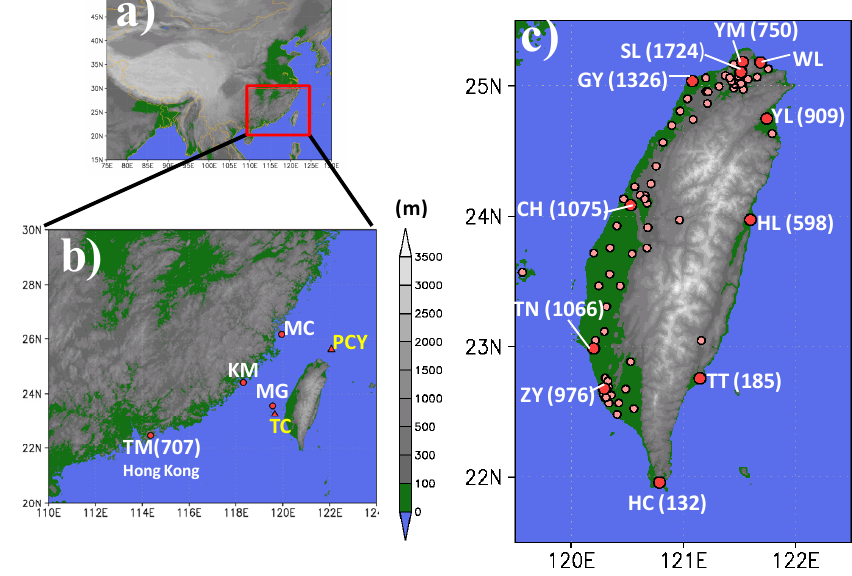
Fig. 1. (a) Location of Taiwan and surrounding countries in East Asia. (b) Location of Taiwan Environmental Protection Administration (TEPA) island stations (MC, KM and MG) and Central Weather Bureau meteorological stations (PCY, TC) in the Taiwan Strait and Ta-Men (TM) station at Hong Kong. The number in parentheses indicates the peak concentration of the TM during this episode. (c) Location of TEPA ground monitoring stations (closed circles) of air quality network in Taiwan with topography. The numbers in parentheses indicate the peak concentrations of the selected stations (big closed circles) during this